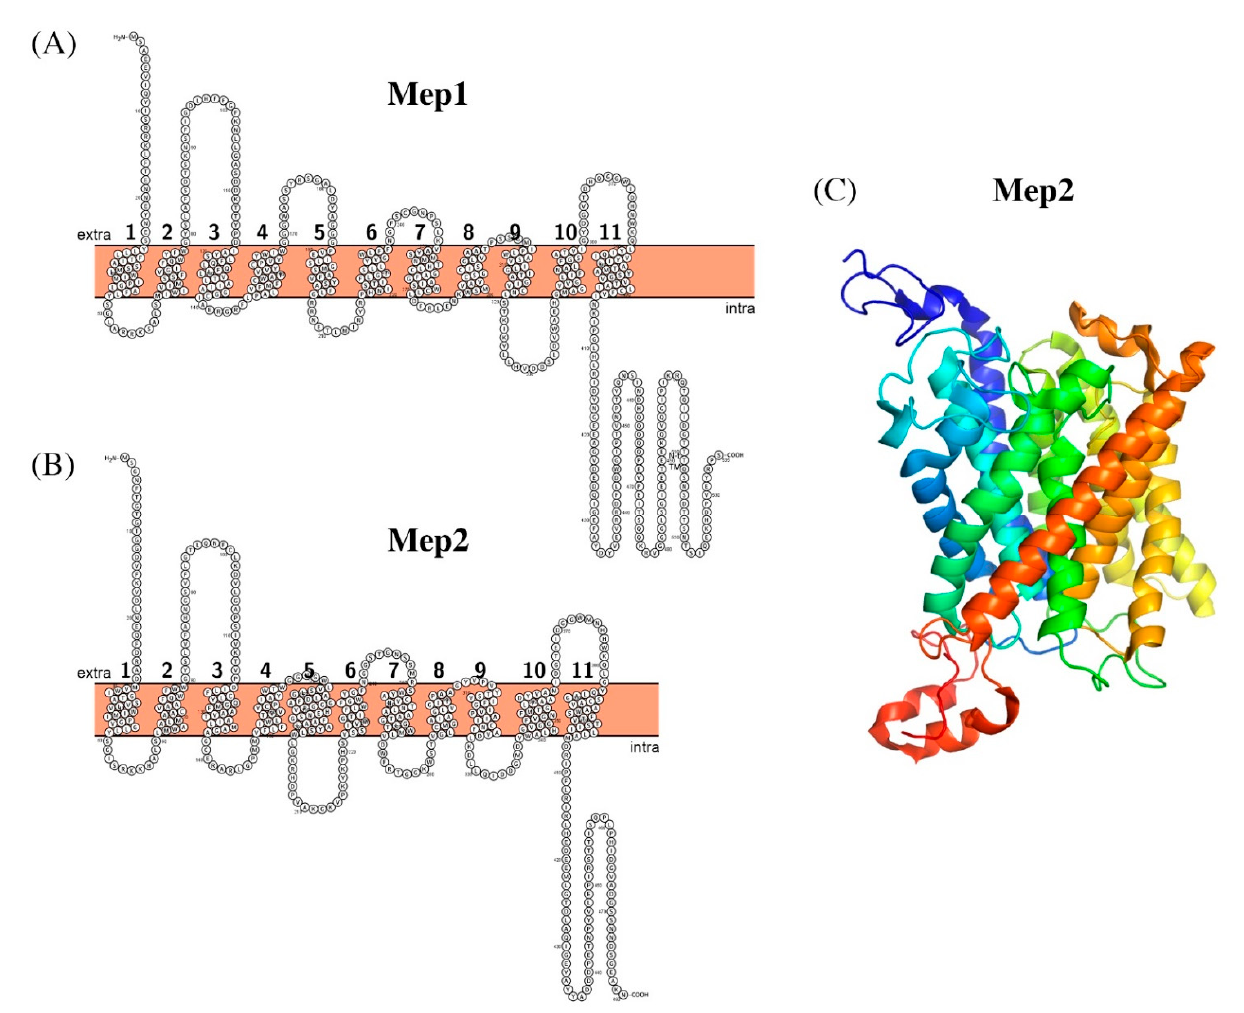
Figure 1. Schematic representation of the secondary structure of Mep1 ( A ) and Mep2 ( B ). Crystal structure of Candida albicans Mep2 ( C ); PDB ID: 5AEZ, colored in rainbow, from blue (N-terminus) to red (C-terminus).